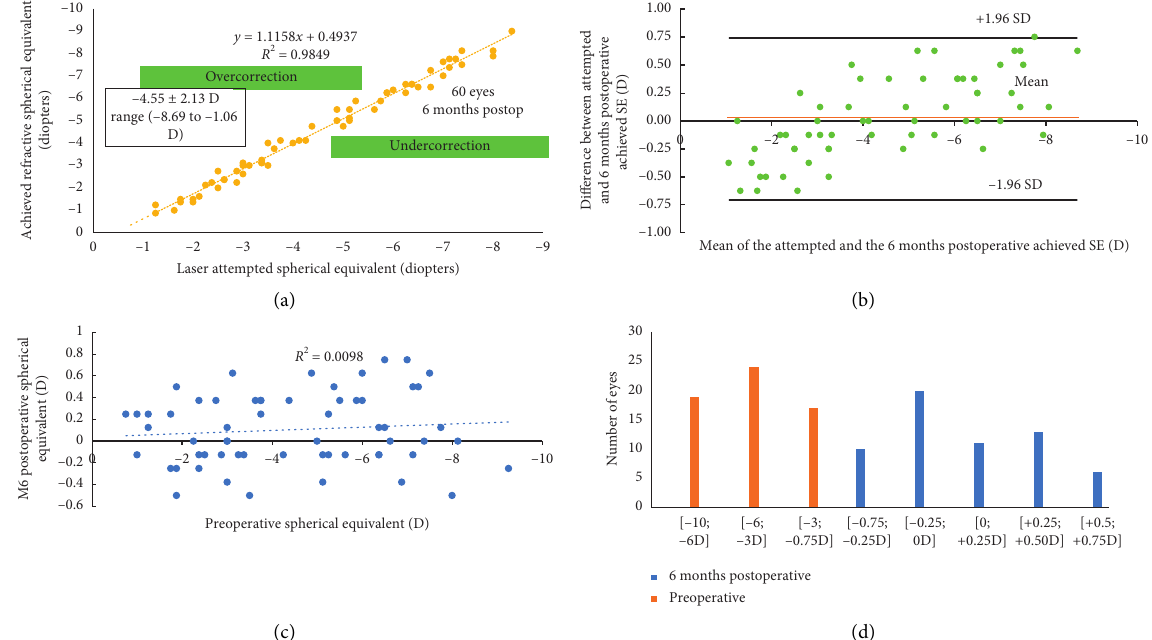
Figure 6: Refractive spherical equivalent (SE) outcomes: distribution of achieved SE outcomes after LASIK at 6 months (a), Bland–Altman distribution of attempted SE (b), correlation between preoperative SE and 6 months postoperative SE (c), and distribution of manifest SE preoperatively and 6 months postoperatively